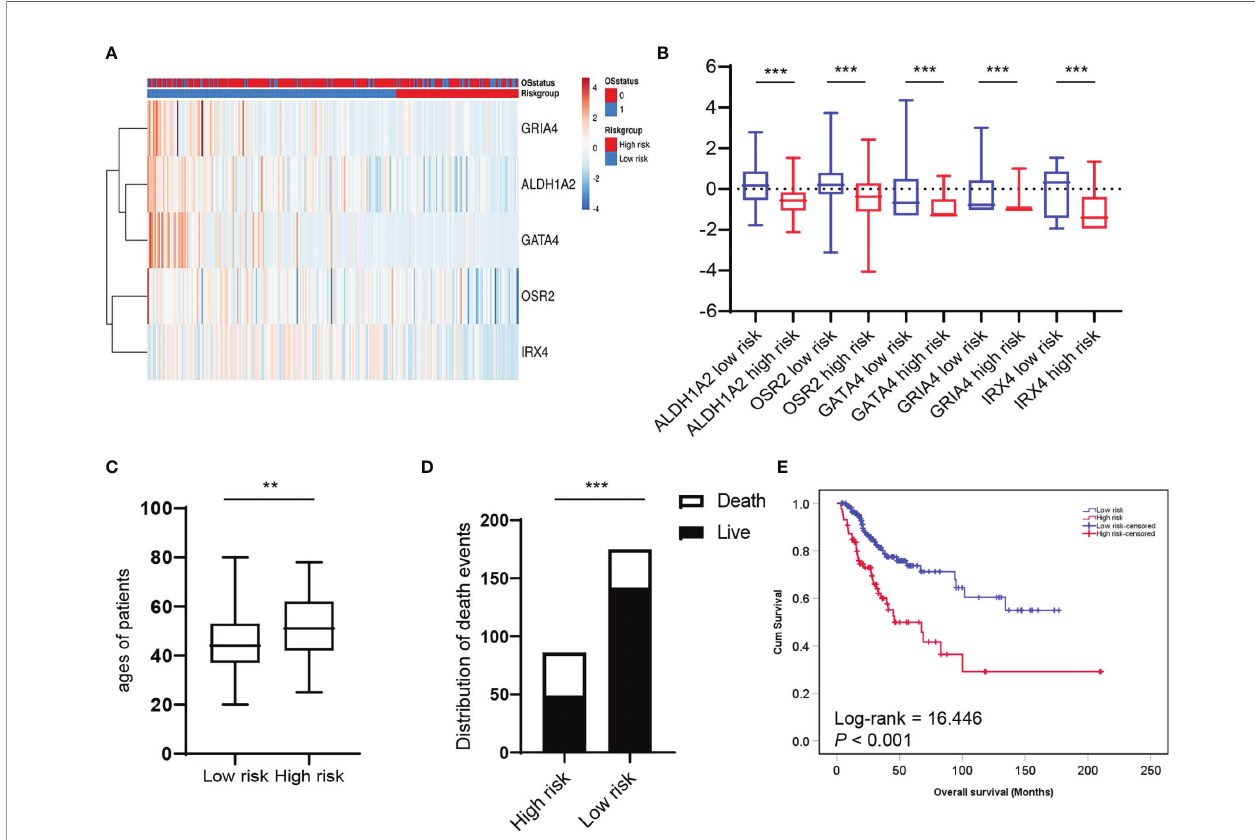
FIGURE 4 | HPV-related methylation-based gene signature isassociated with the clinical prognosisofpatients with cervicalcancer. (A) Heatmap represented HPV-related gene signature expression values (rows) and tumor samples (columns) in low and high-riskgroups bysupervised clustering. (B) Box andwhisker plots of HPV-related gene signature expression values were compared between two risk groups by t -test. The averageages (C) and the distribution ofdeath events (D) between two risk groups were compared. (E) Overallsurvival of two risk groupswas evaluated byKaplan – Meier survivalplot andLog-Rank test. ** P < 0.01, *** P <